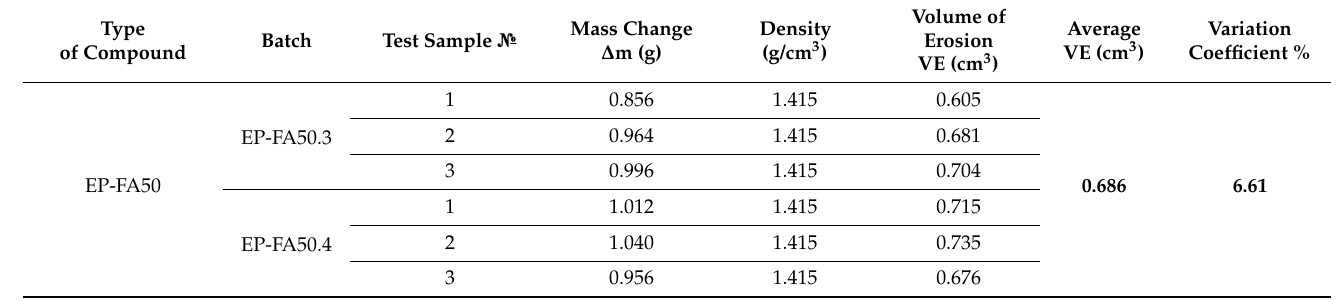
Table A16. Wear of filled epoxy binder (EP-FA50) at 100 ◦ C at an impingement angle of 45 ◦ .